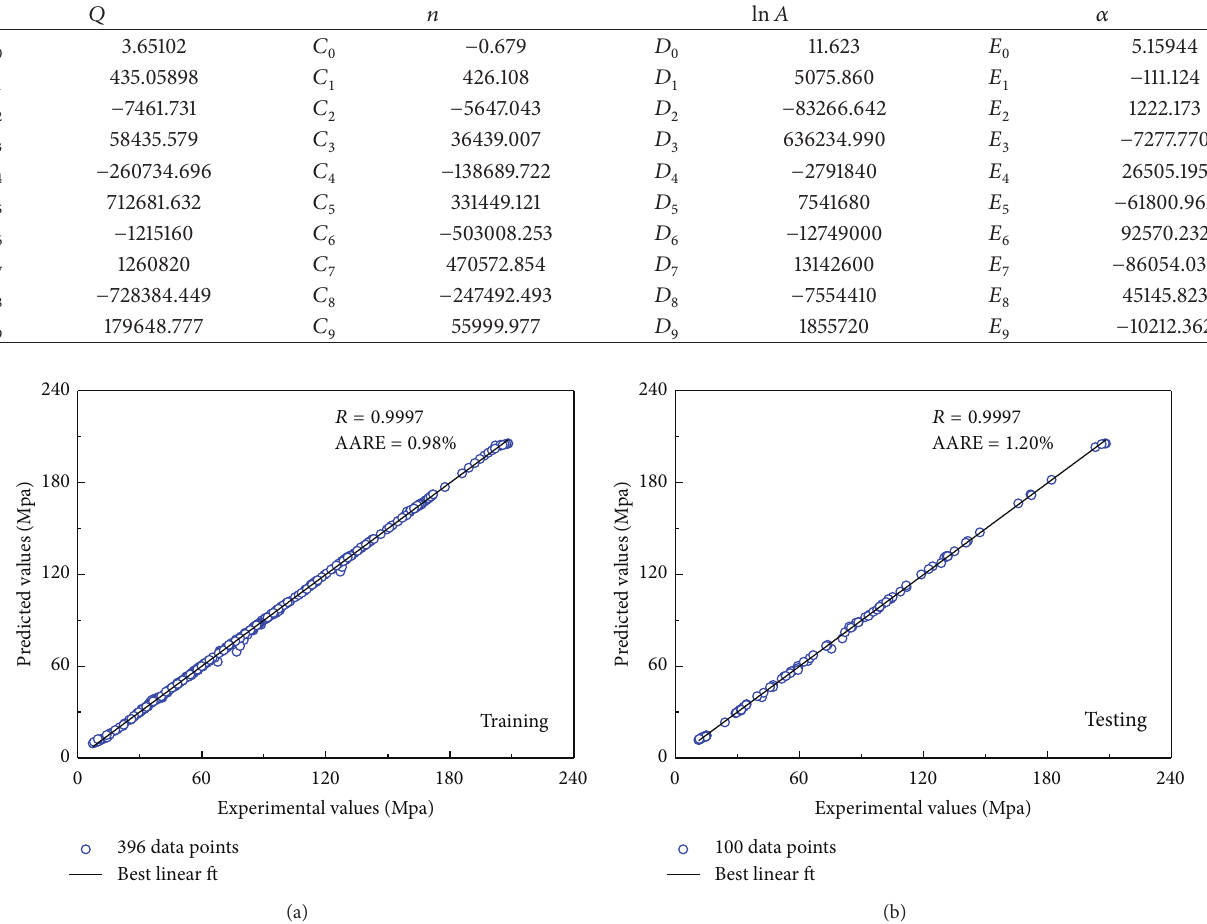
Figure 6: Correlation between the experimental and ANN predicted data for the (a) training and (b) test data.